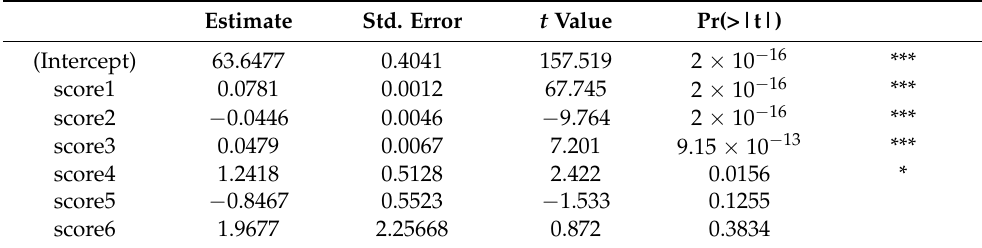
Table A1. The regression results of the pooled air pollution data.